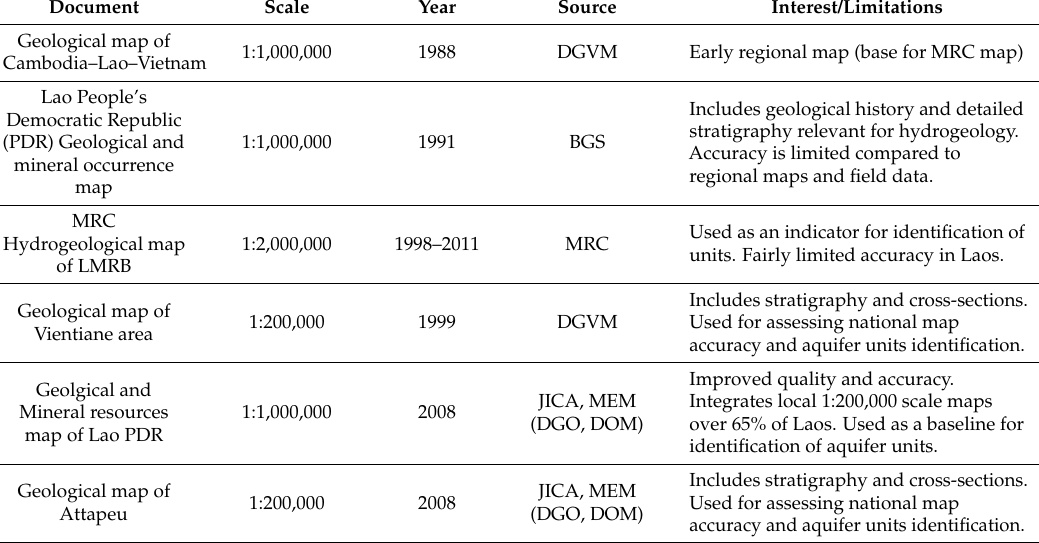
Table 1. Maps used to identify the major aquifer units of Laos (DGVM: Department of Geology and Minerals of Vietnam; BGS: British Geological Survey; MRC: Mekong River Commission. cf. [11–13]; JICA, MEM (DGO, DOM): Japanese International Cooperation Agency; Ministry of Mines (Dept. of Geology, Dept. of